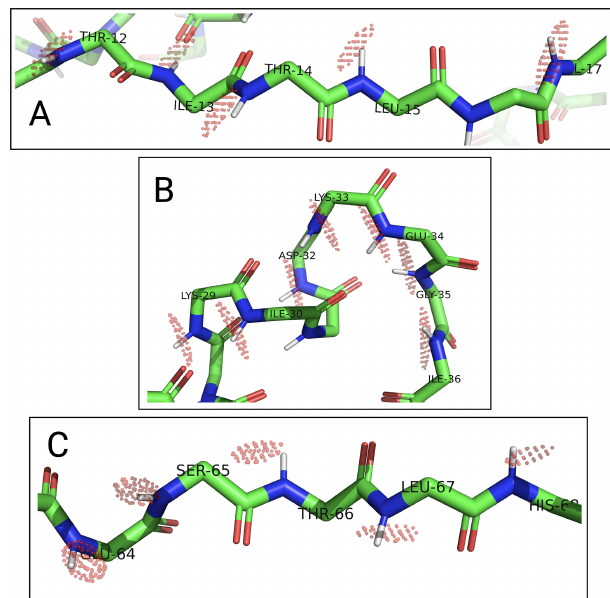
Figure 8. Localisation spaces of backbone amide protons in seg- ments A–C of ubiquitin S57C. The δ thresh. values of individual RMSD amide protons were adjusted to produce similar localisation vol- umes V RMSD . Localisation spaces are shown only for amide pro- tons, for which four PCS values were available. Except for Lys33, the centre of each localisation space shown is less than a bond length from the position of the respective amide